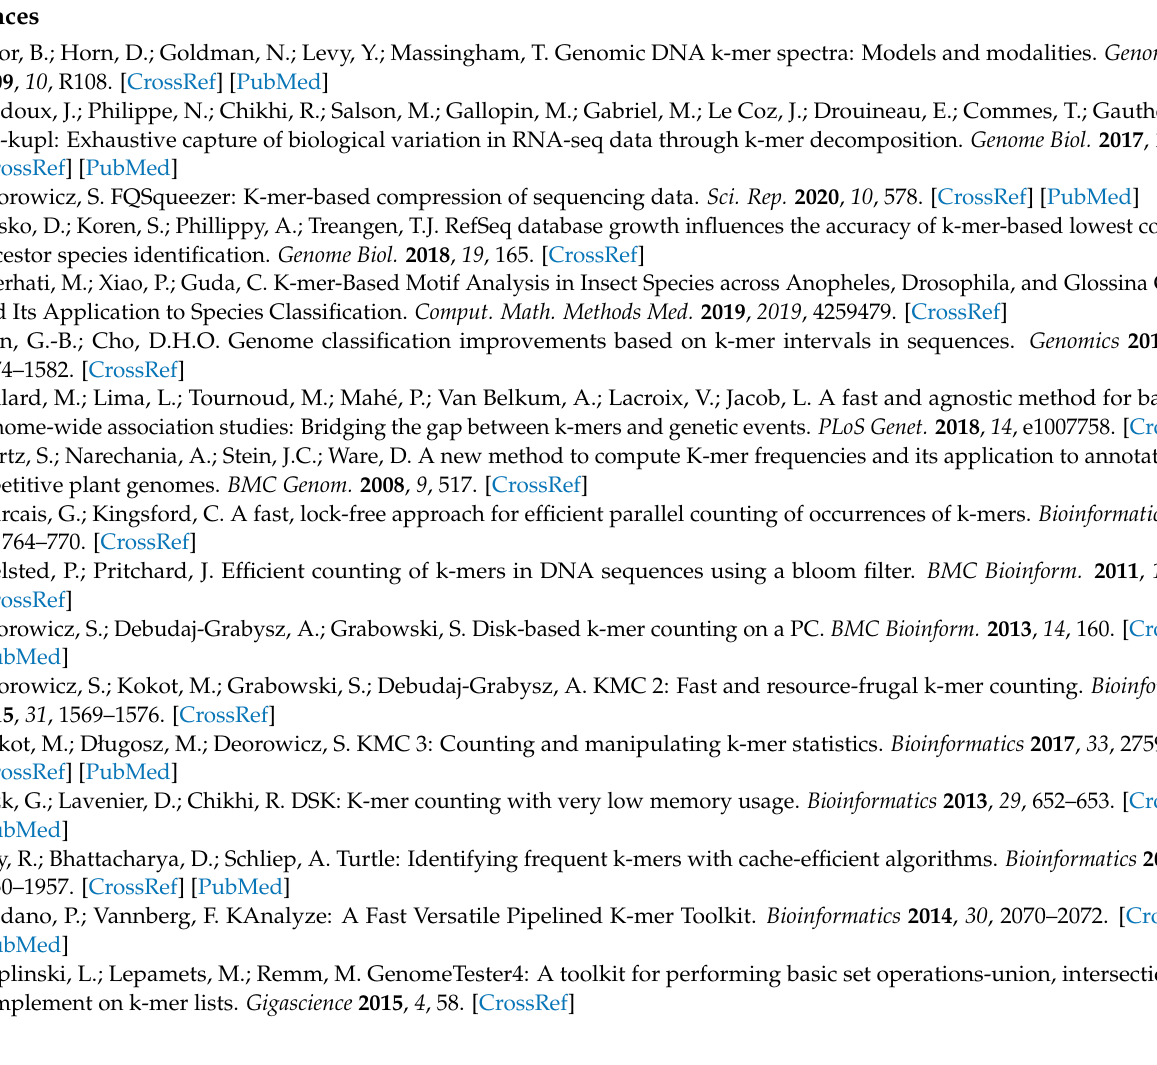
Table S4: Comparison of KMC3 and CHTKC using various GC-ratio datasets; Table S5: Comparison of KMC3 and CHTKC with various sequencing depth; Table S6: Comparison of KMC3 and CHTKC with various sequencing errors; Table S7: Comparison of the time usage of different stages of KMC3 with various sequencing errors; Table S8: Strong scalability comparison of KMC3 and CHTKC; Table S9: Weak scalability comparison of KMC3 and CHTKC; Table S10: Comparison of the dumper of KMC3, CHTKC and Revised KMC3 with various sequencing